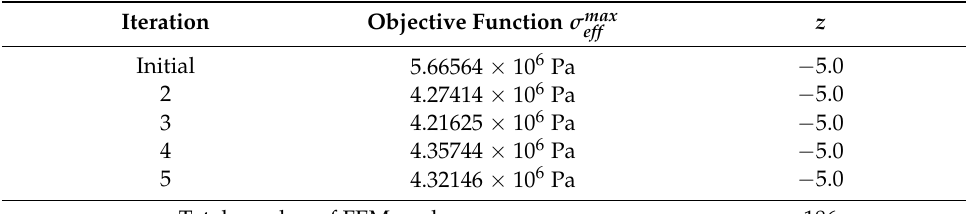
Table 6. The iteration history of objective function ( α = 45 ◦ ).